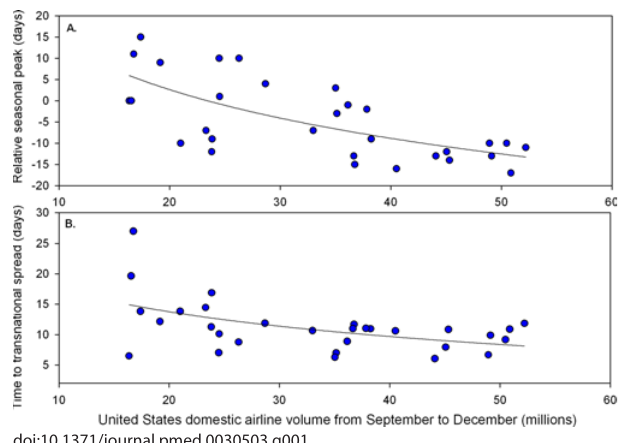
Figure 1. Patterns of Timing (A) and Spread (B) of 30 Infl uenza Epidemics in the US, Together with Trends in Air Travel